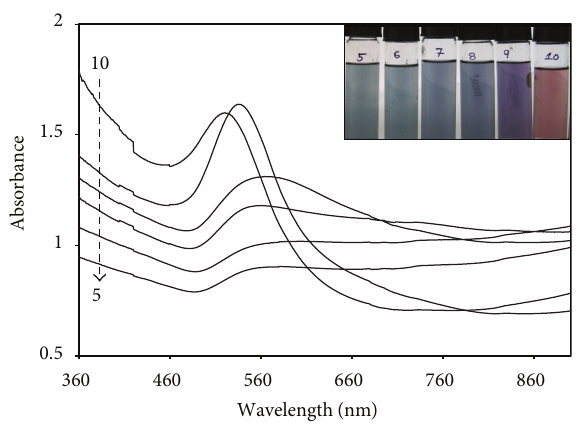
Figure 3: UV-Vis spectra depicting the effect of initial pH of ECF on GNP synthesis after 24 hours of